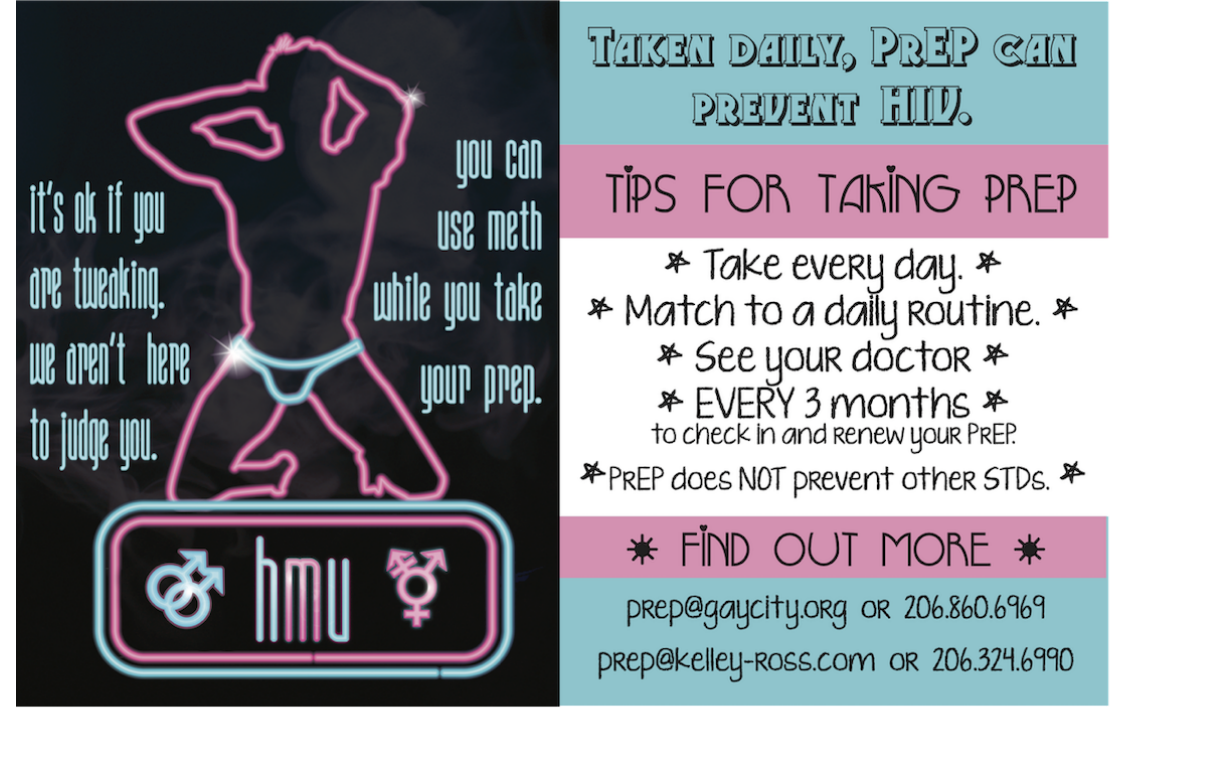
Figure 1. Revised educational cards that include the recommendations of focus group and interview participants. HMU: Hit Me Up; PrEP: pre-exposure prophylaxis; STD: sexually transmitted